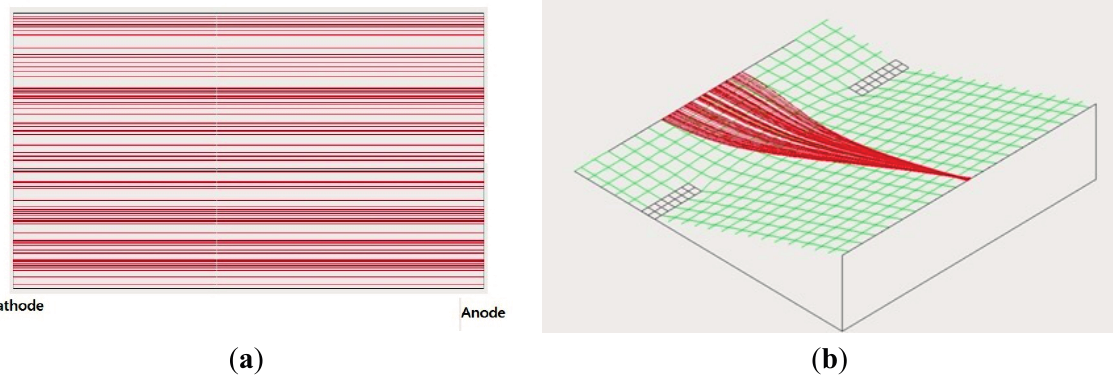
Figure 3. Trajectories of emitted electrons ( a ) without and ( b ) with focusing cup design. Vertical axis in ( b ) represents electric potential V .